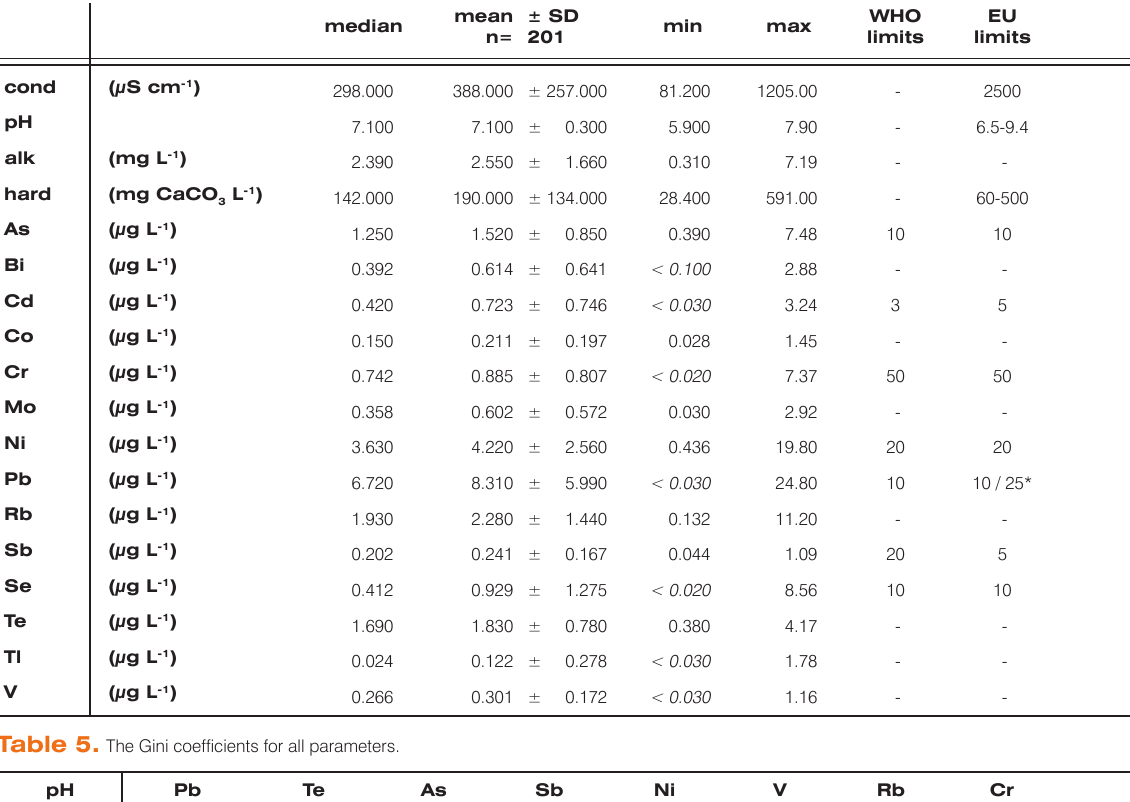
Table 4. The results: mean, min and max ±standard deviation for all 201 samples + WHO and EU regulations; * - from 2014, the maximum concentration of Pb in drinking water will amount only to 10 μg L -1 .